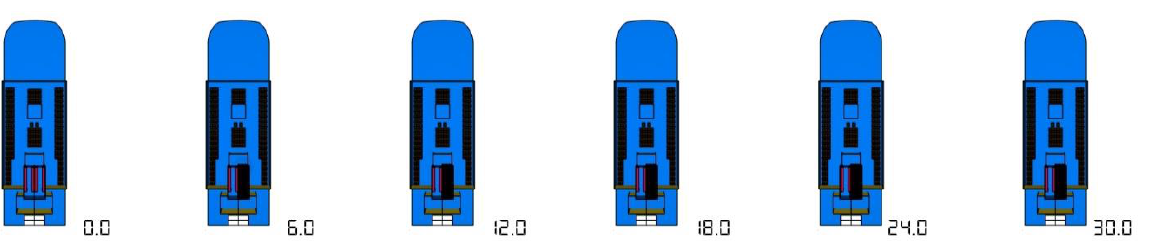
Figure 15. Simulation of scenario 1.